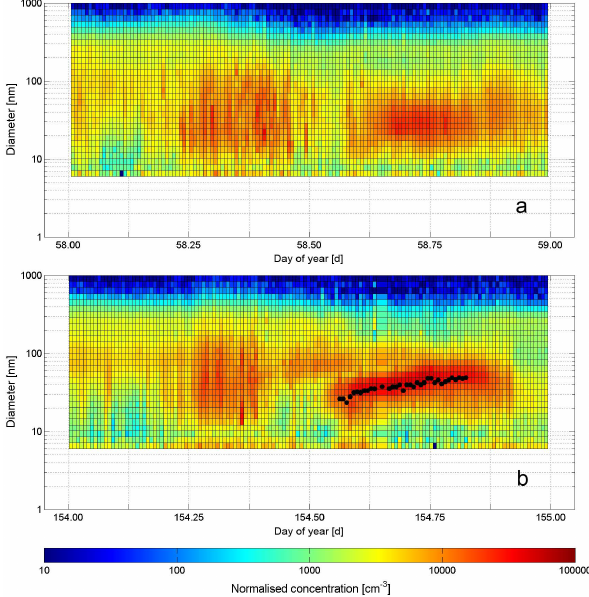
Fig. 5. Contour plots of normalised particle number concentrations showing two major automotive road traffic emission events corre- sponding to morning and afternoon rush hours on Friday, 27 Febru- ary 2009 (a) and Wednesday, 3 June 2009 (b) . Significant growth of the primary Aitken-mode particles on (b) is indicated as time series of the fitted number median mobility diameter for the Aitken mode by black